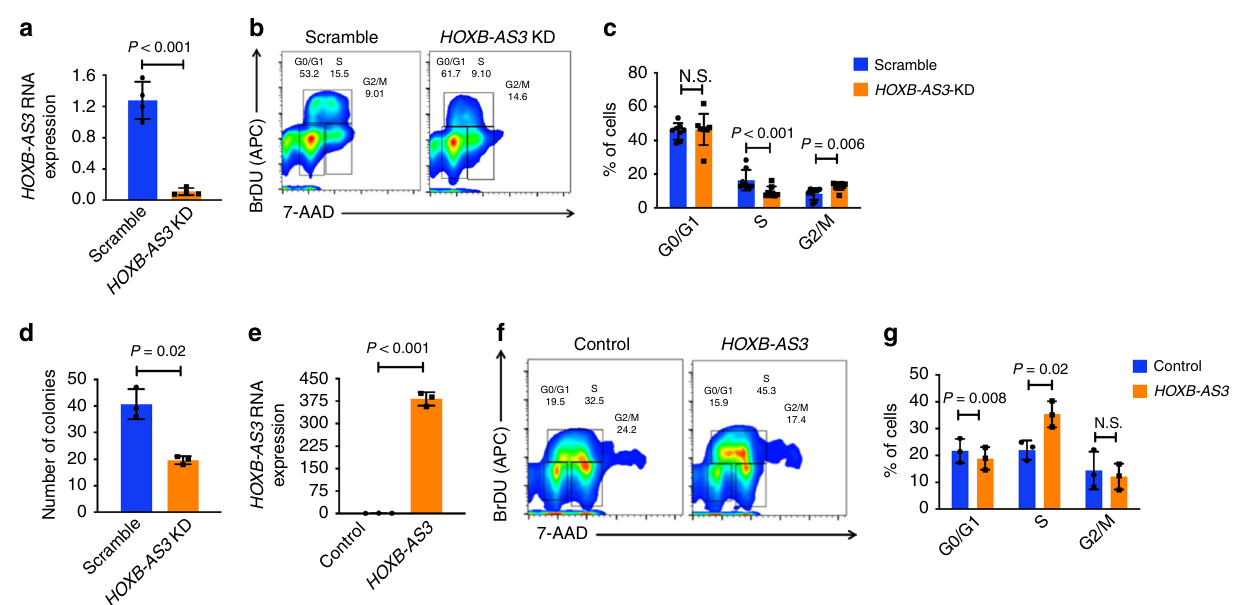
Fig. 2 The HOXB-AS3 lncRNA regulates cell proliferation of AML cells. a Relative HOXB-AS3 RNA expression in OCI-AML3 cells treated with scramble versus anti- HOXB-AS3 gapmers ( HOXB-AS3 KD). b Cell-cycle analysis in scramble versus anti- HOXB-AS3 gapmer-treated OCI-AML3 cells. Results of a representative experiment are shown. c Comparison of the percentages of cells at each stage of the cell cycle (G0/G1, S, and G2/M phases) in OCI-AML3 cells treated with scramble versus anti- HOXB-AS3 gapmers. Results of six independent experiments are shown. d Comparison of the numbers of colonies formed by scramble versus anti- HOXB-AS3 gapmer-treated OCI-AML3 cells in colony-forming unit assays. Results of three independent experiments are shown. e Relative HOXB-AS3 RNA expression in K-562 cells transfected with empty vector (control) versus a HOXB-AS3 -overexpressing vector. f Cell- cycle in K-562 cells transfected with control versus HOXB-AS3 -overexpressing vectors. Results of a representative experiment are shown. g Comparison of the percentages of cells at each stage of the cell cycle (G0/G1, S, and G2/M phases) in K-562 cells transfected with control versus a HOXB-AS3 - overexpressing vectors. Results of three independent experiments are shown. P values were calculated using paired two-sided t -tests. In the fi gures, heights of boxplots indicate mean values with standard deviation. Error bars indicate highest and lowest values in each population. Source data are provided as a Source Data fi patient (Fig. 3a). HOXB-AS3 KD led to a signi fi cant decrease in